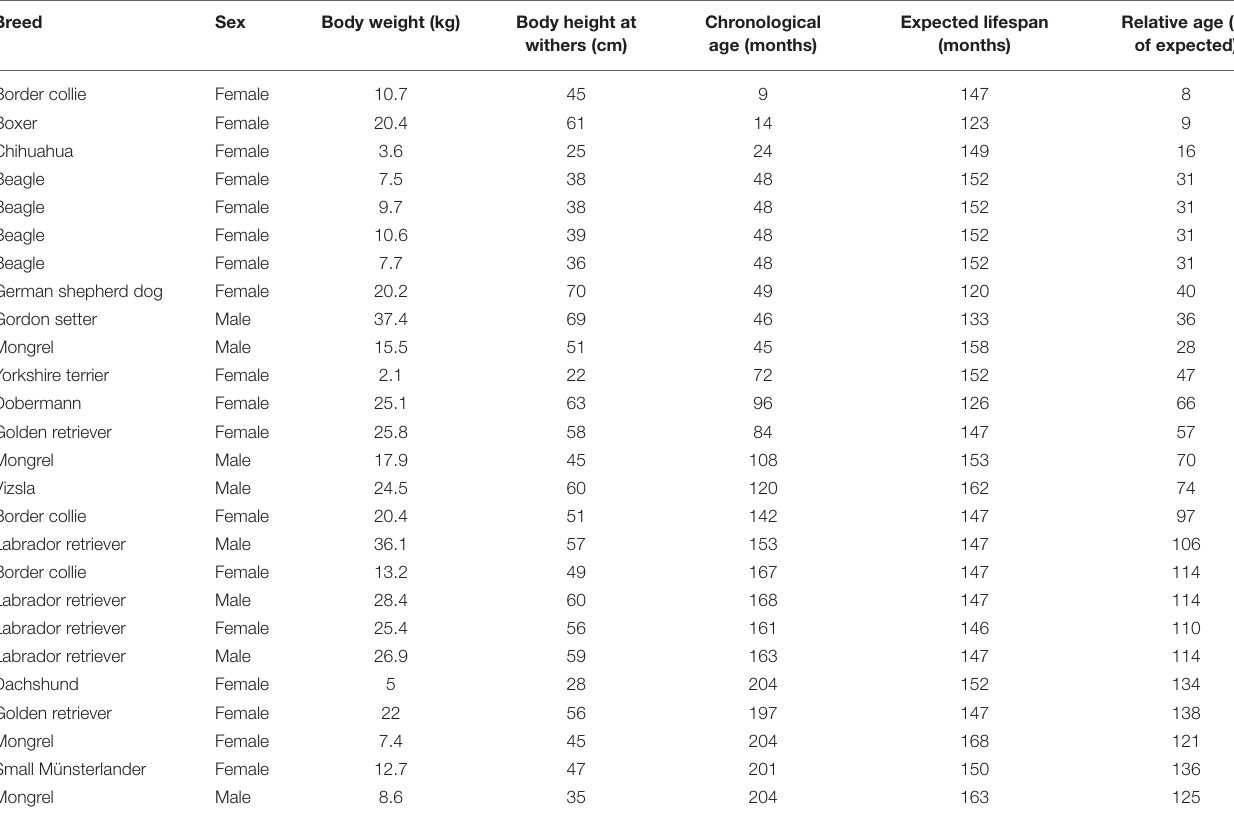
TABLE 1 | Dogs included in study 1.